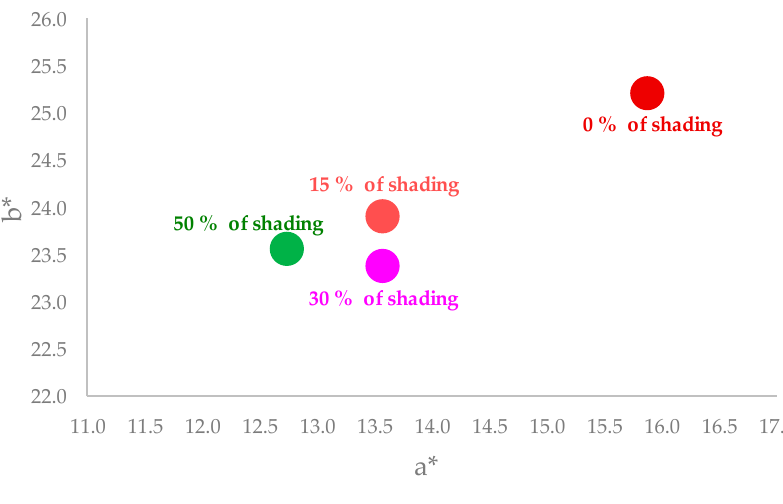
Figure 15. Shading effects of fruit color.